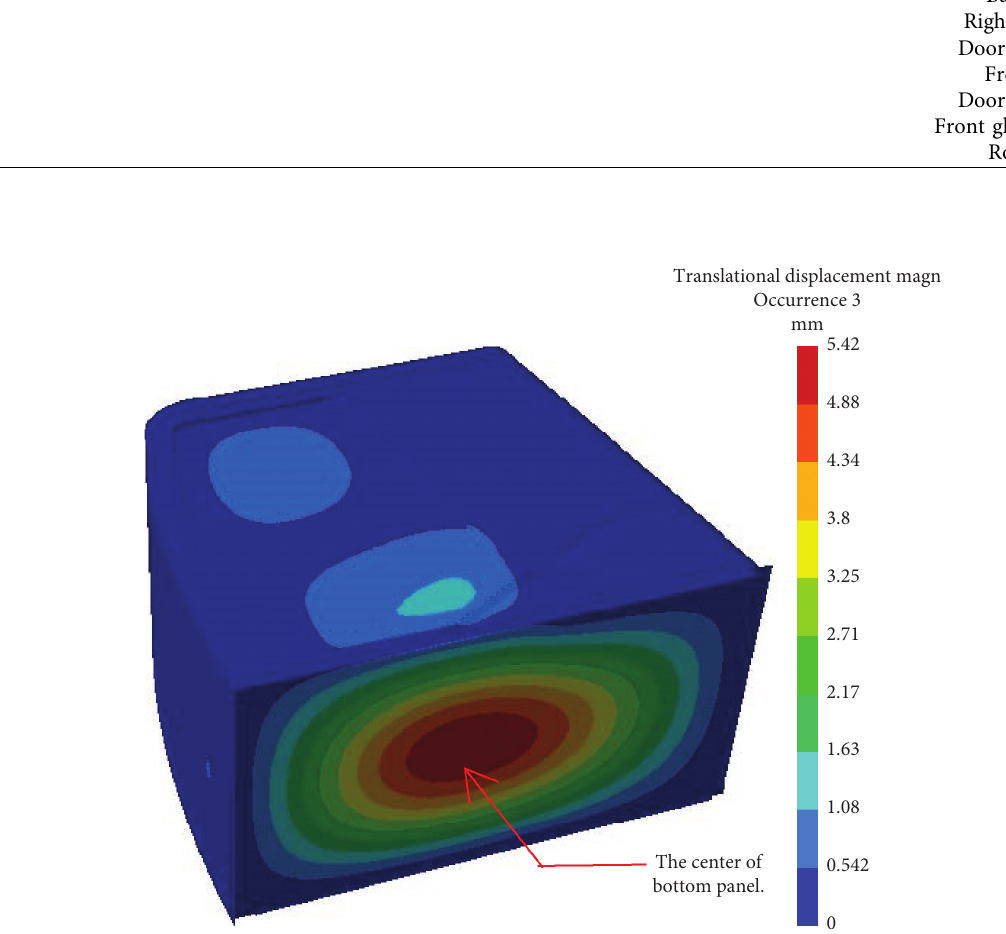
Figure 15: Third-order vibroacoustic coupling